Question: Give a one-sentence summary of this figure.
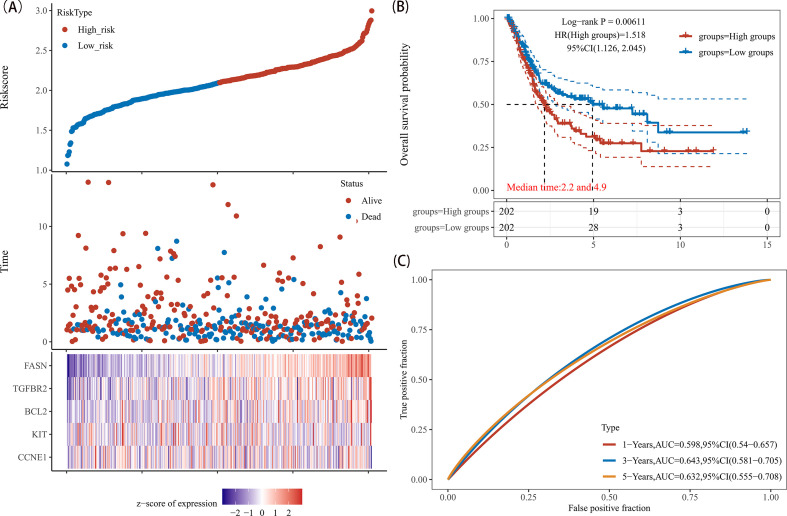
Answer: Prognostic model of BCa. (A) Distribution of patient risk scores (top), patient survival status and follow−up time (middle), and z−score–normalized expression heatmap of the five signature genes (bottom). (B) Kaplan–Meier overall survival curves for high−risk (red) versus low−risk (blue) groups. (C) Time−dependent receiver operating characteristic (ROC) curves for the risk model at 1, 3 and 5 years.